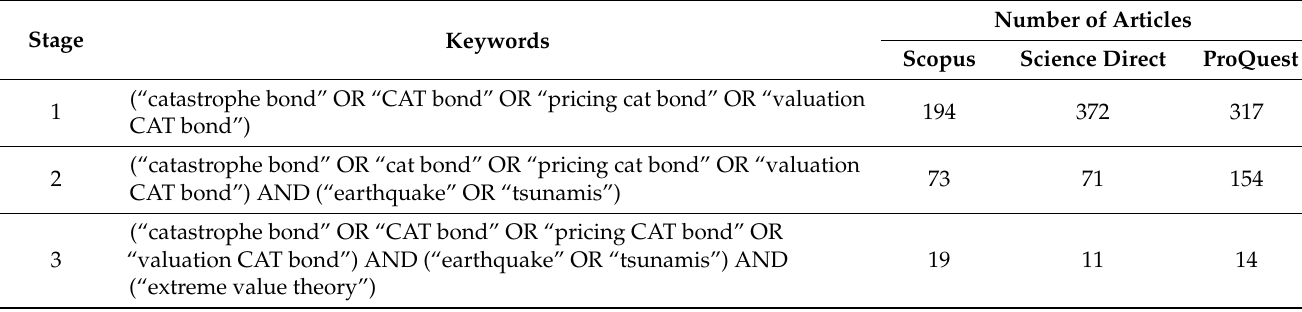
Table 2. Numbers of articles obtained from Scopus, ScienceDirect, and ProQuest.